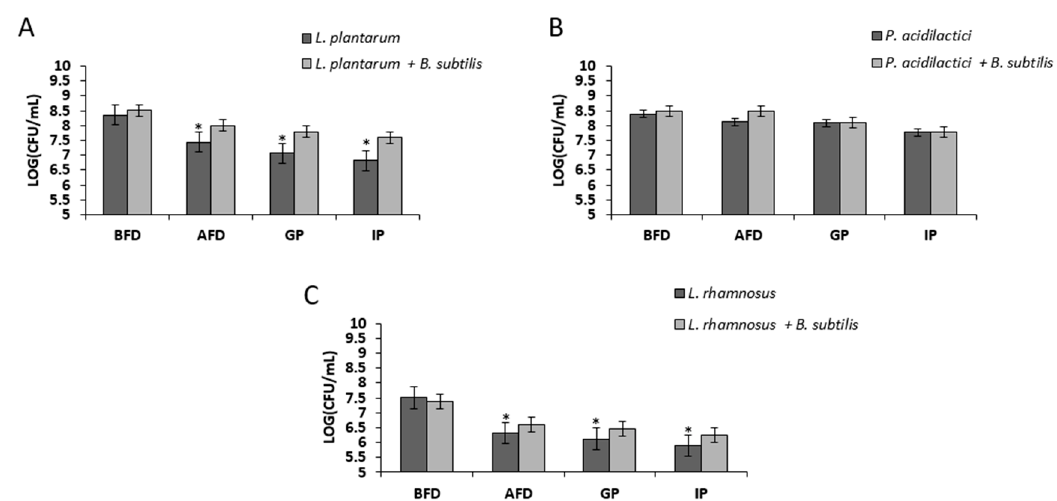
Figure 6. Bio-coating maintains LAB survivability during gastrointestinal digestion in vitro following freeze-drying. Mono- and dual-species cultures of B. subtilis and LAB cells were generated in MMRS medium during bacterial growth for 8 h in 37 °C , 50 rpm. Survival rates of LAB cells were determined based on CFU counts following freeze-drying and during gastro-intestinal digestion in vitro. * p < 0.05 for comparison of the control and tested samples. Error bars represent standard deviation (SD). BFD—before freeze-drying; AFD—after freeze-drying; GP—gastric phase; IP—intestinal phase. The survival rates are shown for ( A ) L. plantarum , ( B ) P. acidilactici , and ( C ) L. rhamnosus .